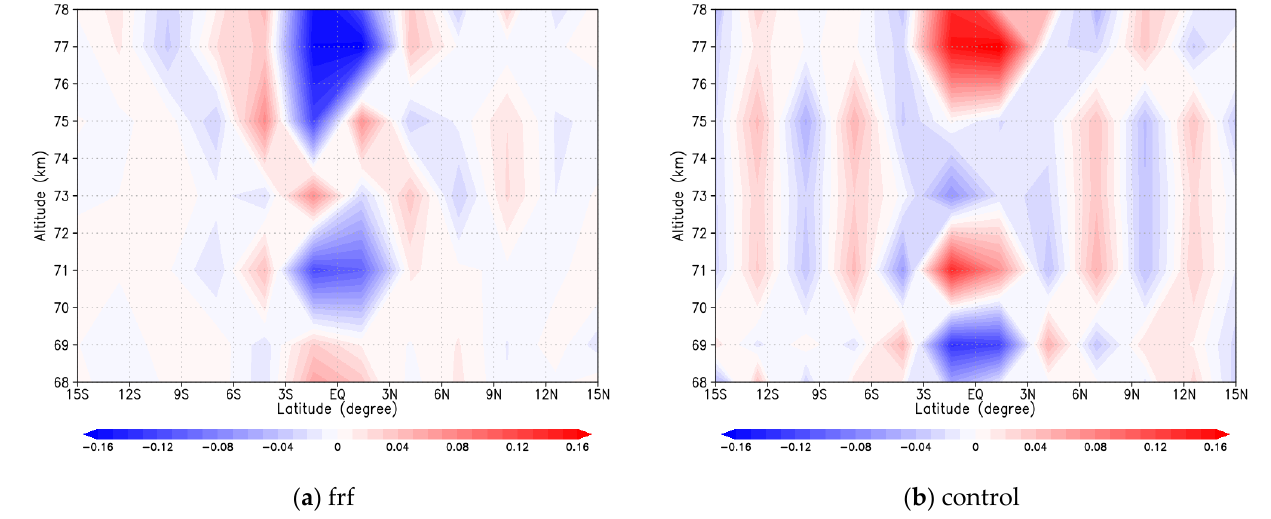
Figure 6. Latitude – altitude cross-sections of acceleration and deceleration (m/s day −1 ) estimated by the EP flux (color) for the ( a ) frf and ( b ) control cases. Time averages for 20 Earth days are conducted after the Kevin wave is reproduced.